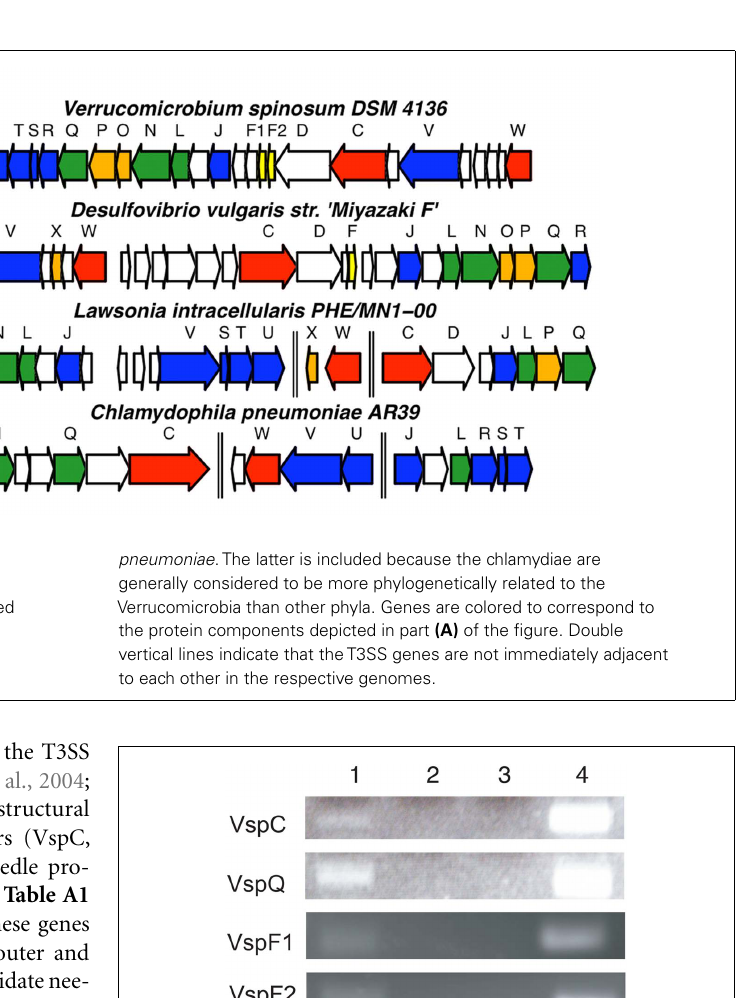
FIGURE 2 | Detection ofVspC,VspQ,VspF1, andVspF2 expression by RT-PCR. Lane 1: V. spinosum RNA in the presence of reverse transcriptase and DNA polymerase; Lane 2: water (PCR negative control); Lane 3: V. spinosum RNA in the absence of reverse transcriptase and presence